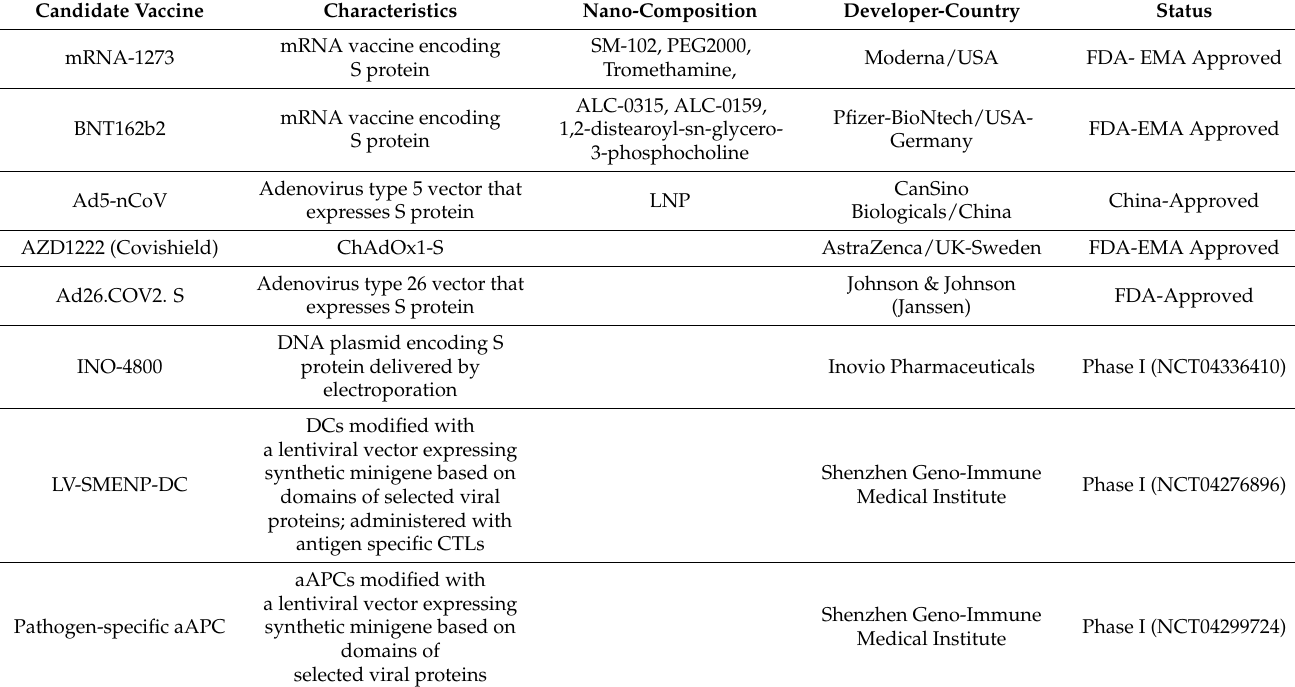
Table 4. Clinical phase SARS-CoV-2